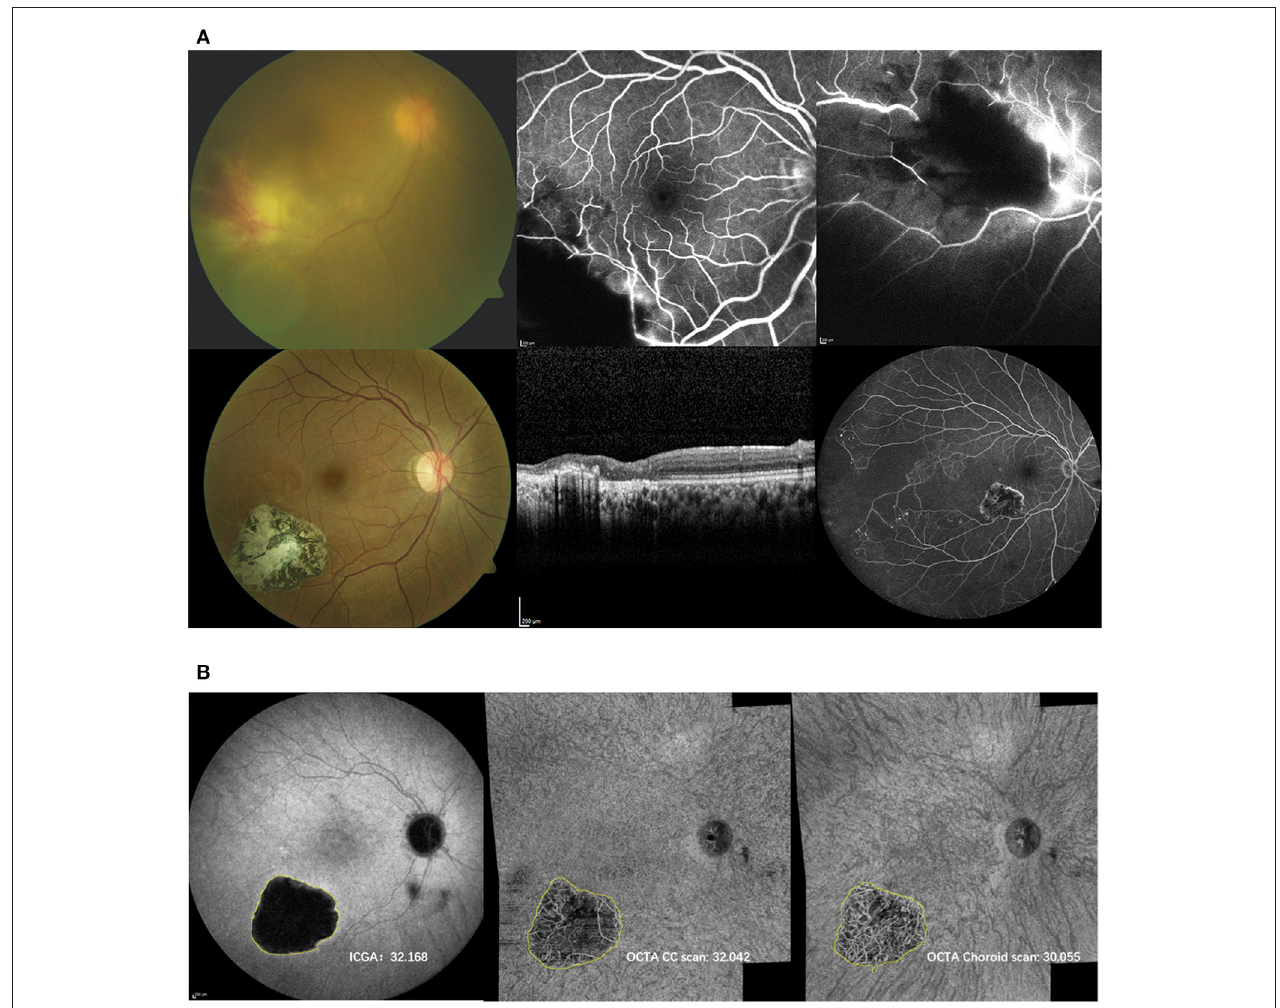
FIGURE 1 | (A) Top: Initial presentation of the right eye of a 27-year-old woman with panuveitis OU (DD toxoplamosis retinochoroidtis). Color fundus (CF) image (top left) reveals localized retinochoroiditis with hemorage and vasculitis. Fluorescein angiography (FA) (top middle and right) shows blockage, non-perfusion and vasculitis. Bottom: Follow up: CF (left), optical coherence tomography (middle) and FA acquired at the same time when ICG and OCTA shown in (B) were performed. CF depicts inactive well circumscribed chorioretinal scar with pigment migration. On OCT the scar is accompanied with inner and outer retinal atrophy. Wide field FA exhibits the inactive scar with extensive areas of non-perfusion exceeding the scarred area. (B) Indocyanine angiography (ICGA) (left) and OCTA choriocapillaris (CC, middle) and choroidal (right) scans of respective patient including the measurements of the lesion (mm 2 ). The lesion appeared larger on ICG than on the OCTA CC and choroidal